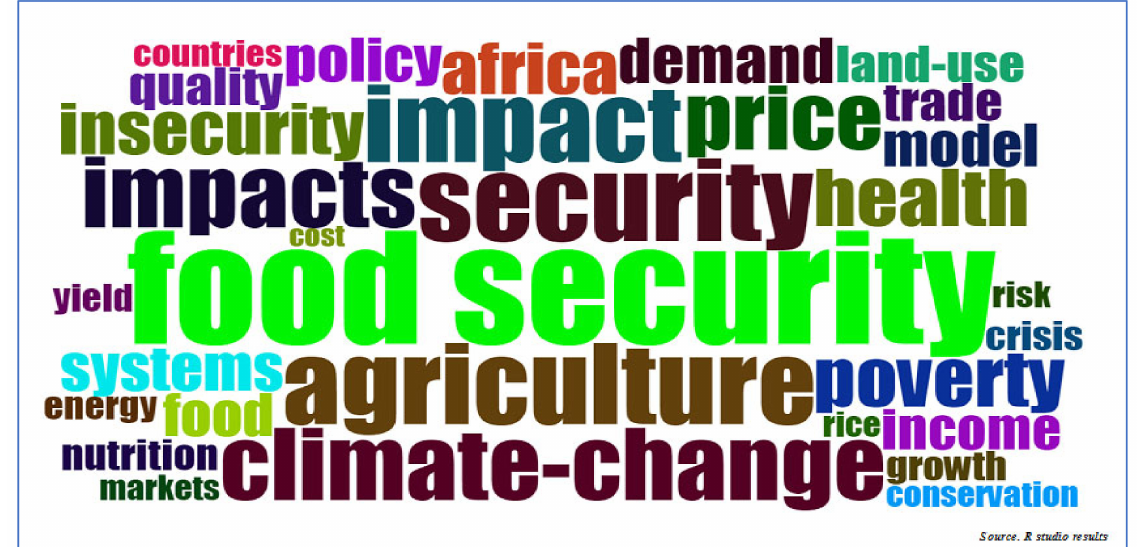
Figure 8. Word map of keywords. Source R studio